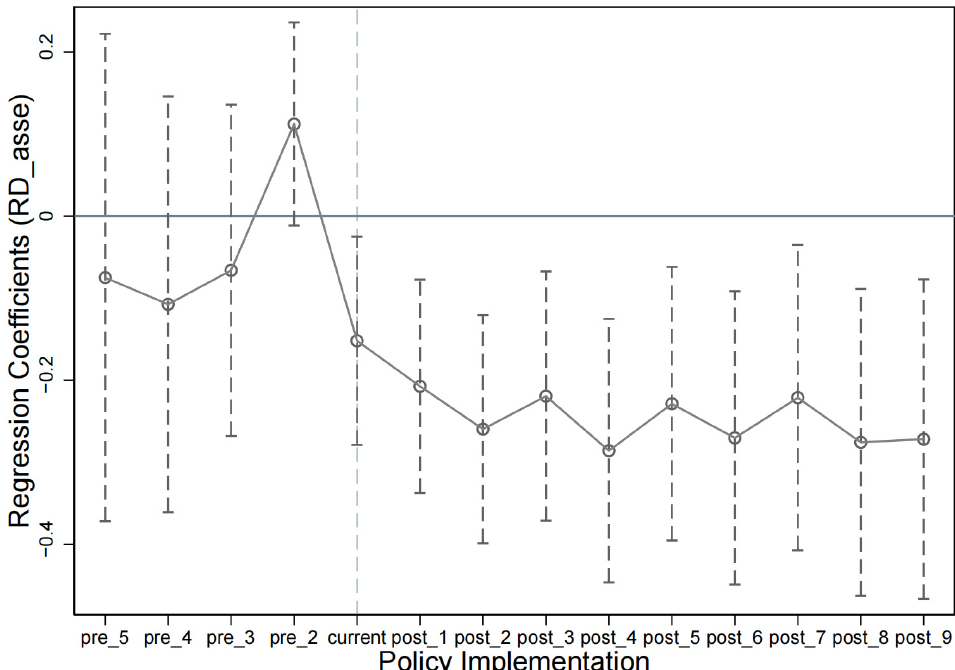
Figure 2. Test for parallel trend and policy dynamic effects.